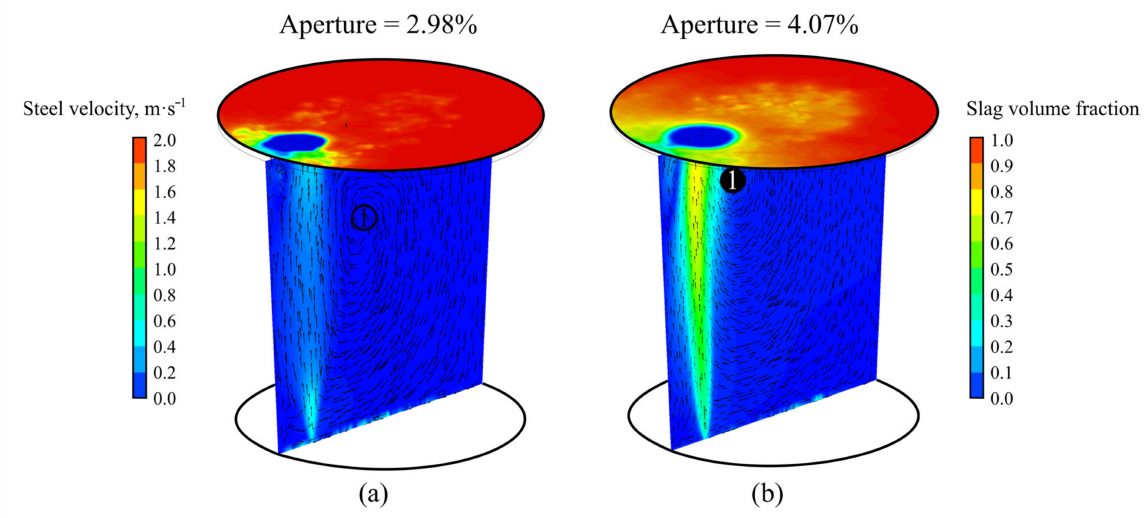
Figure 5. Overlapped slag aperture contours, contours, and velocity vectors of steel for ( a ) 0.3 Nm 3 · min − 1 and ( b ) 0.5 Nm 3 · min − 1